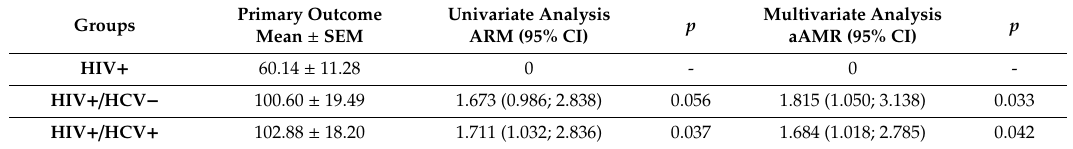
Table 4. Di ff erences in the number of copies of integrated HIV-DNA among study groups. Primary Outcome Univariate Analysis Groups Mean ± SEM ARM (95%